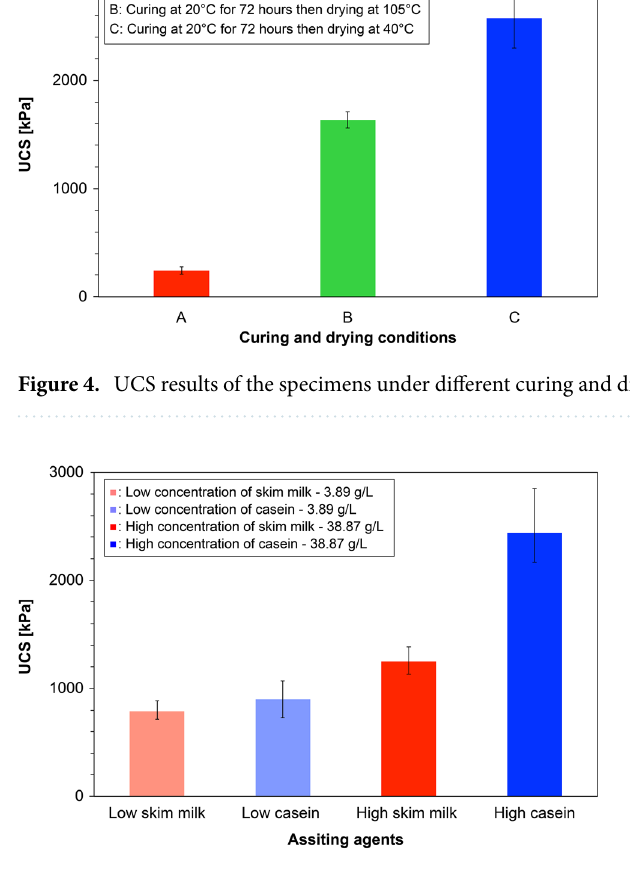
Figure 5. UCS results of the ECIP-treated specimens assisted using the low- and high-concentrations of skim milk and